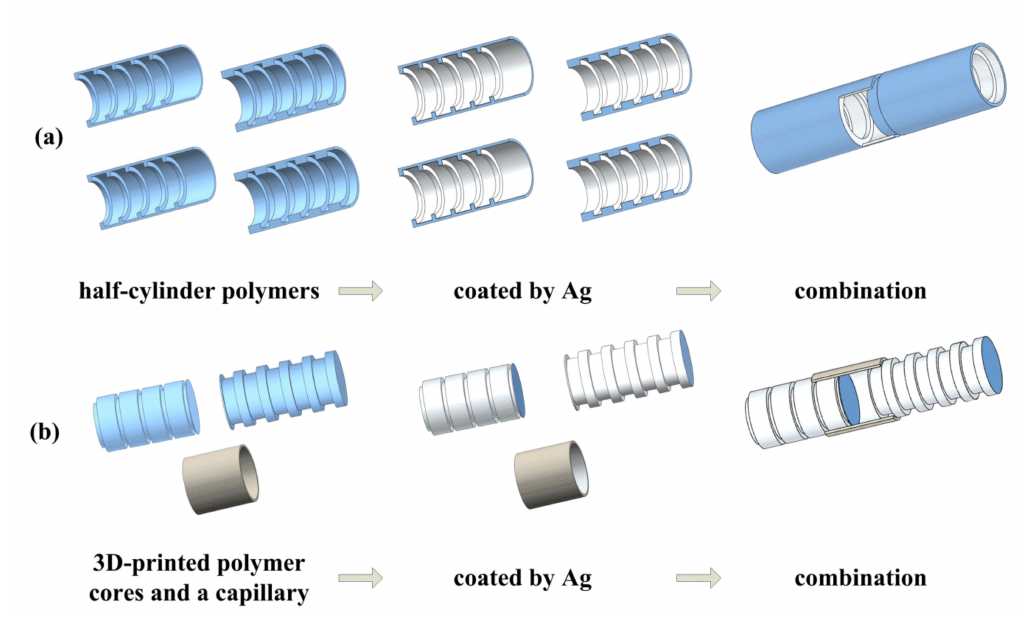
Figure 4. Sketch maps of the device fabrication process with the substrates outside ( a ) or inside ( b